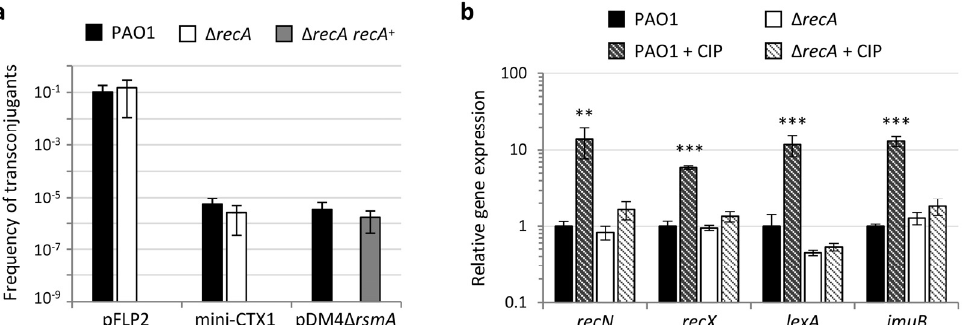
Figure 1. Confirmation of the essential role of RecA in homologous recombination and activation of the SOS response in P. aeruginosa . ( a ) Frequency of transconjugants obtained for P. aeruginosa PAO1, the ∆ recA mutant, and the complemented strain ∆ recA recA + upon conjugation-mediated acquisition of the replicative plasmid pFLP2, the self-integrative suicide plasmid mini-CTX1 or the suicide plasmid pDM4 ∆ rsmA , that requires homologous recombination for chromosome integration. Frequencies are expressed as transconjugant CFUs/recipient CFUs ratio. ( b ) Relative mRNA levels of selected SOS response genes ( recN , recX , lexA , and imuB ) determined by qRT-PCR in P. aeruginosa PAO1 and the ∆ recA mutant cultured in MH in the absence or in the presence of 0.25 × MIC ciprofloxacin (CIP) (0.031 and 0.008 µ g/mL for PAO1 and ∆ recA , respectively; Table 1). Values are the mean ( ± SD) of three independent experiments. Asterisks indicate a statistically significant increase in relative gene expression with respect to the untreated control (unpaired t test: ** p < 0.01; *** p < 0.001).